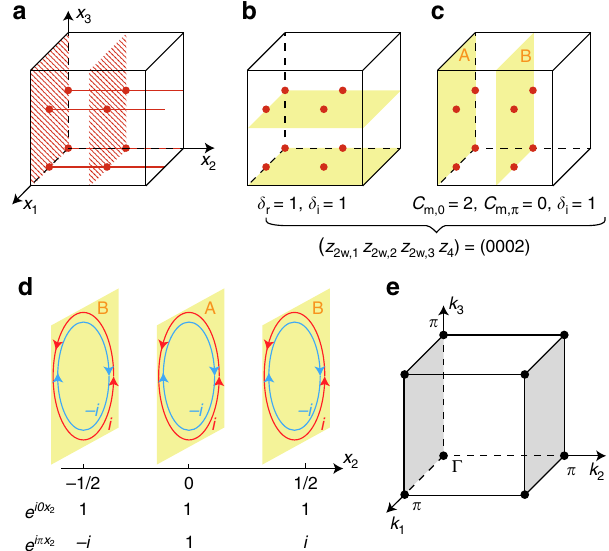
Fig. 3 Two layer constructions for space group P 2/ m , sharing the same set of SI of (0002). a All symmetry elements of the space group in one unit cell, including eight inversion centers (red solid circles), four rotation axes (red solid lines), and two mirror planes (shaded planes). b , c LC1 and LC2 de fi ned in the text, respectively. They have distinct topological invariants but identical indicators. d 3D Blöch wave functions in LC2 as superpositions of 2D Blöch wave functions with coef fi cients e ik 2 x 2 . Here we use red and blue loops to represent the 2D wave functions having mirror eigenvalues i and − i , respectively, wherein i wave functions have Chern number 1 and − i wave functions have Chern number − 1. For A-eLC the 3D Blöch wave functions at k 2 = 0 and k 2 = π have the same mirror eigenvalues, leading to identical mirror Chern numbers at k 2 = 0 and k 2 = π . Although for B-eLC the Blöch wave functions at k 2 = 0 and k 2 = π have opposite mirror eigenvalues, leading to opposite mirror Chern numbers at k 2 = 0 and k 2 = π . e The two mirror-invariant planes (gray planes) in Brillouin